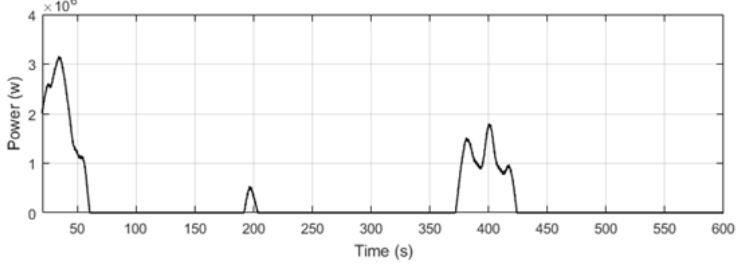
Figure 11. The excess power sent to the PEM electrolyzer.